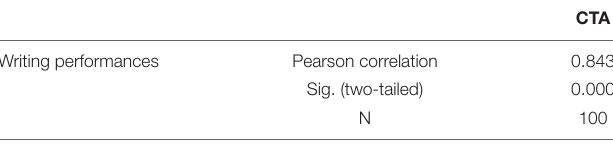
TABLE 7 | Pearson correlation: CTA with learning